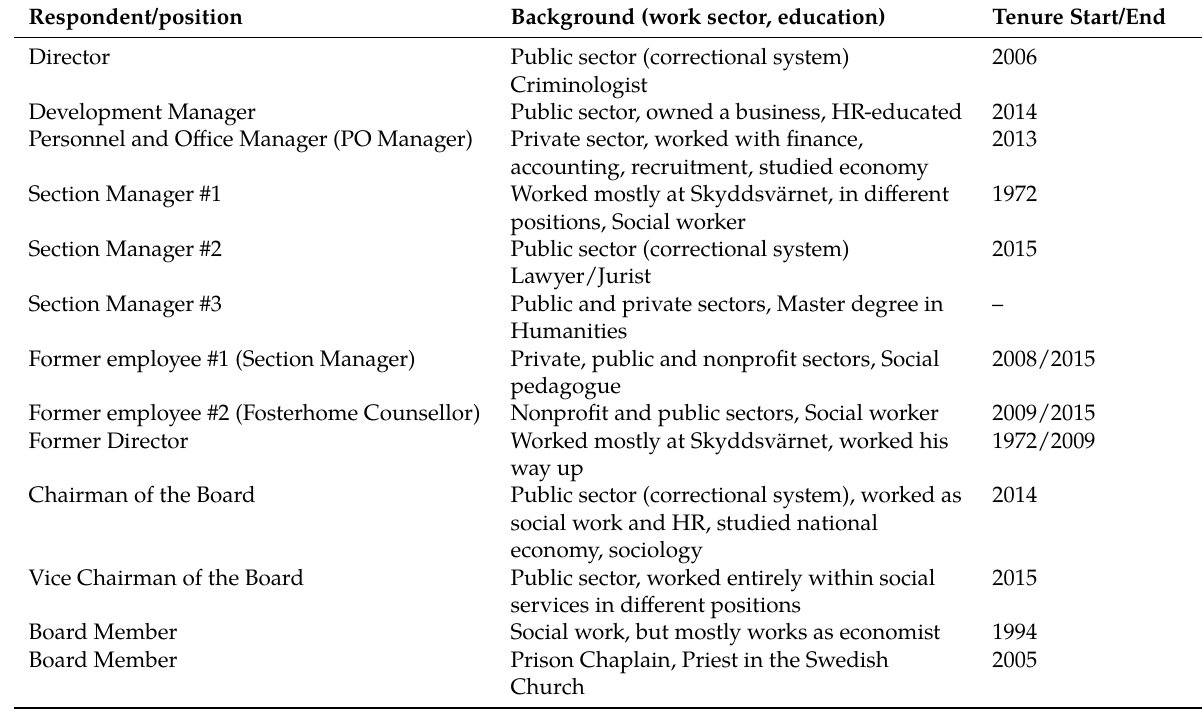
Table 1: Composition of